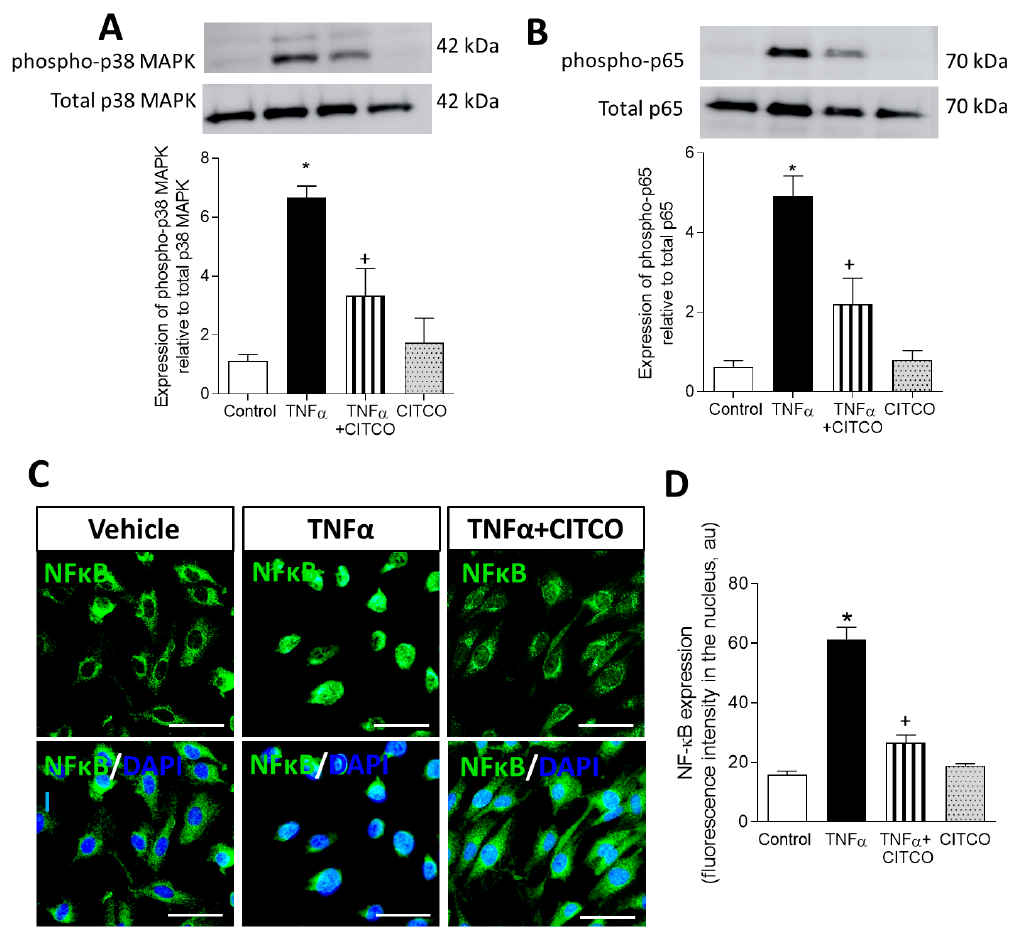
Figure 5. CITCO treatment diminishes p38 MAPK and p65 NF- κ B phosphorylation induced by TNF α in HUVEC. Cells were pretreated with vehicle (0.1% DMSO) or CITCO (3 µ M) for 24h before stimulation with TNF α (20 ng/mL) for 30 min. Representative Western blots of ( A ) phospho p38/total p38 MAPK and ( B ) phospho p65/total p65 in HUVEC subjected to the different treatments. Data represent mean ± SEM of protein densitometry ( n = 5 for each group). * p < 0.05 relative to vehicle group, + p < 0.05 relative to TNF α stimulated cells. ( C ) Representative images of NF- κ B translocation into nuclei after CITCO treatment. Immunoreactivity was visualized using Alexa Fluor 488 (NF κ B, green) secondary antibody. Nuclei were stained with DAPI (blue). Scale bar = 50 µ m. ( D ) Fluorescence intensity was quantified using ImageJ. Values are expressed as mean ± SEM ( n = 3 for each group). * p < 0.05 relative to vehicle group, + p < 0.05 relative to TNF α stimulated